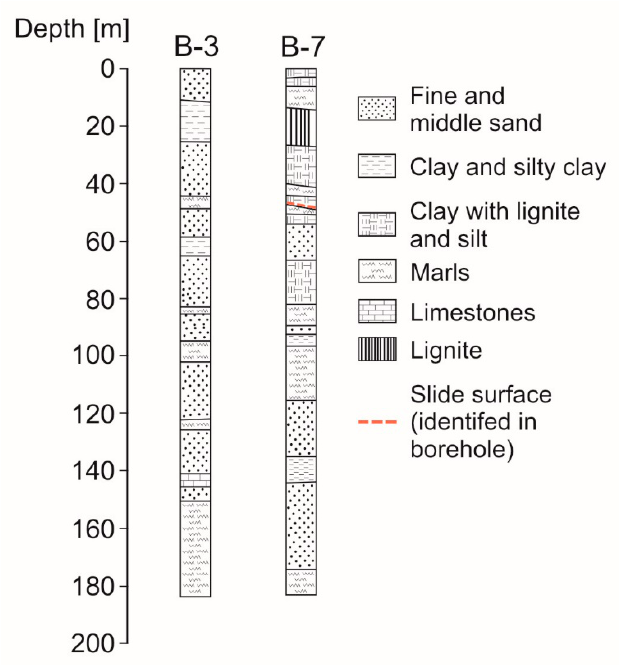
Figure 4. Characteristic geological profiles based on B-3 and B-7 boreholes in the region of the 18S landslide in the Be ł chatów mine.